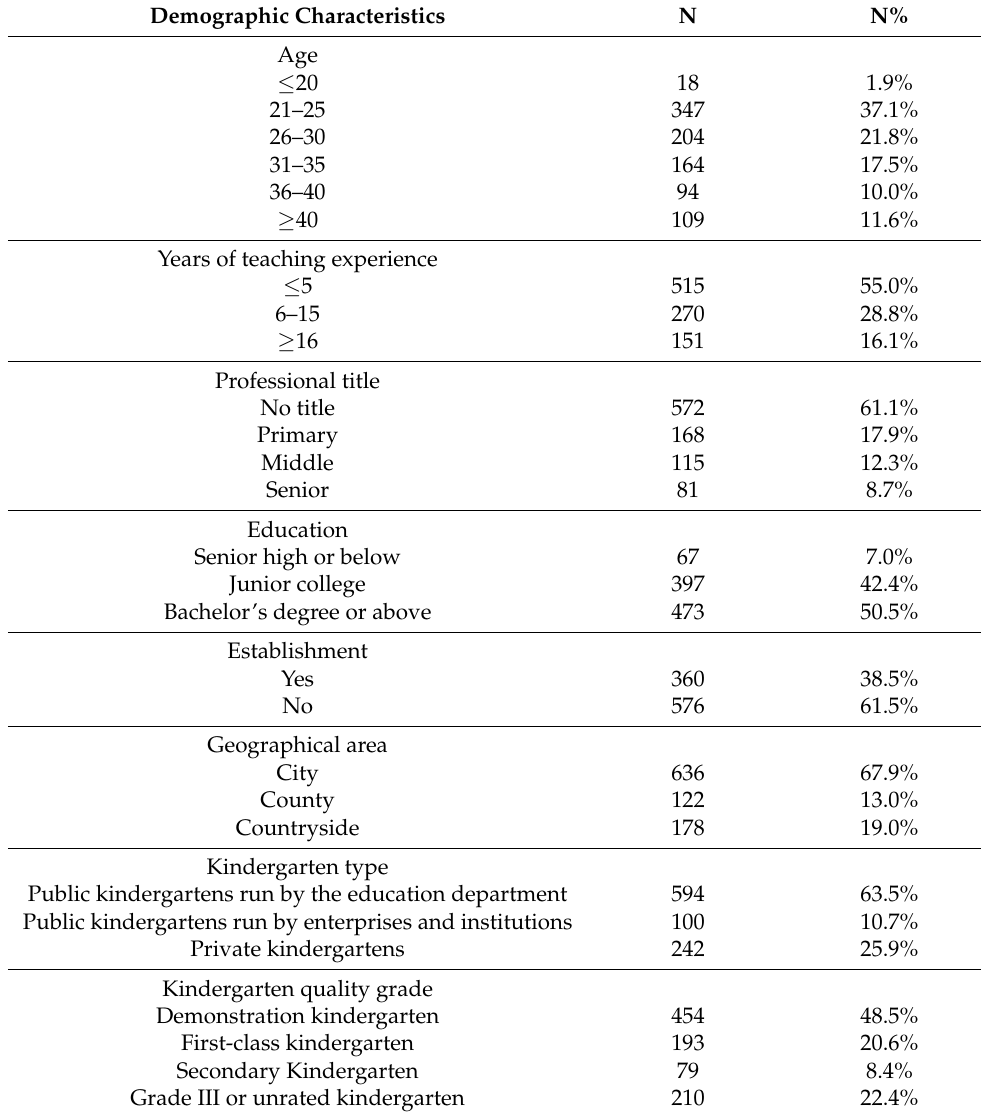
Table 1. Participants’ characteristics (N =